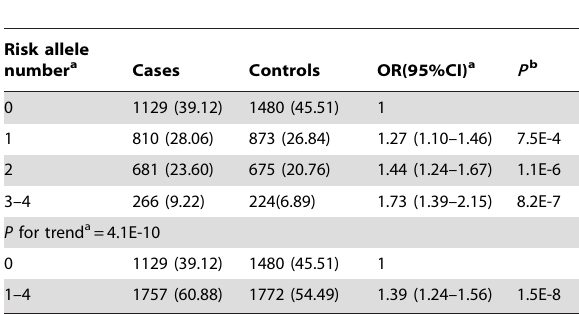
Figure S2 Linkage disequilibrium analysis of 7 single- nucleotide polymorphisms consistently associated with type 2 diabetes risks. Linkage disequilibrium (LD) strength in controls was shown in the diamonds represented by r 2 values. A moderate LD (r 2 : 0.19–0.64) was indicated between the most significant SNP rs7923837 and the other significant 6 SNPs, with r 2 value being 0.19 for rs4646957, 0.20 for rs1111875, 0.43 for rs947591 respectively. Figure S3 Meta-analysis of 3 single-nucleotide polymor- phisms from IDE-KIF11-HHEX locus with type 2 diabe- tes in Chinese populations. The pooled odds ratios (ORs) for type 2 diabetes were significant for rs1111875 (pooled OR =1.16, P , 0.0001), rs5015480 (pooled OR =1.18, P , 0.0001) in the fixed- effects model, and for rs7923837 (pooled OR = 1.19, P , 0.0001) in the random-effects mode. Table S1 Stratification analysis for two independent SNPs (rs7923837 and rs1111875) and risk of type 2 diabetes in additive genetic model.